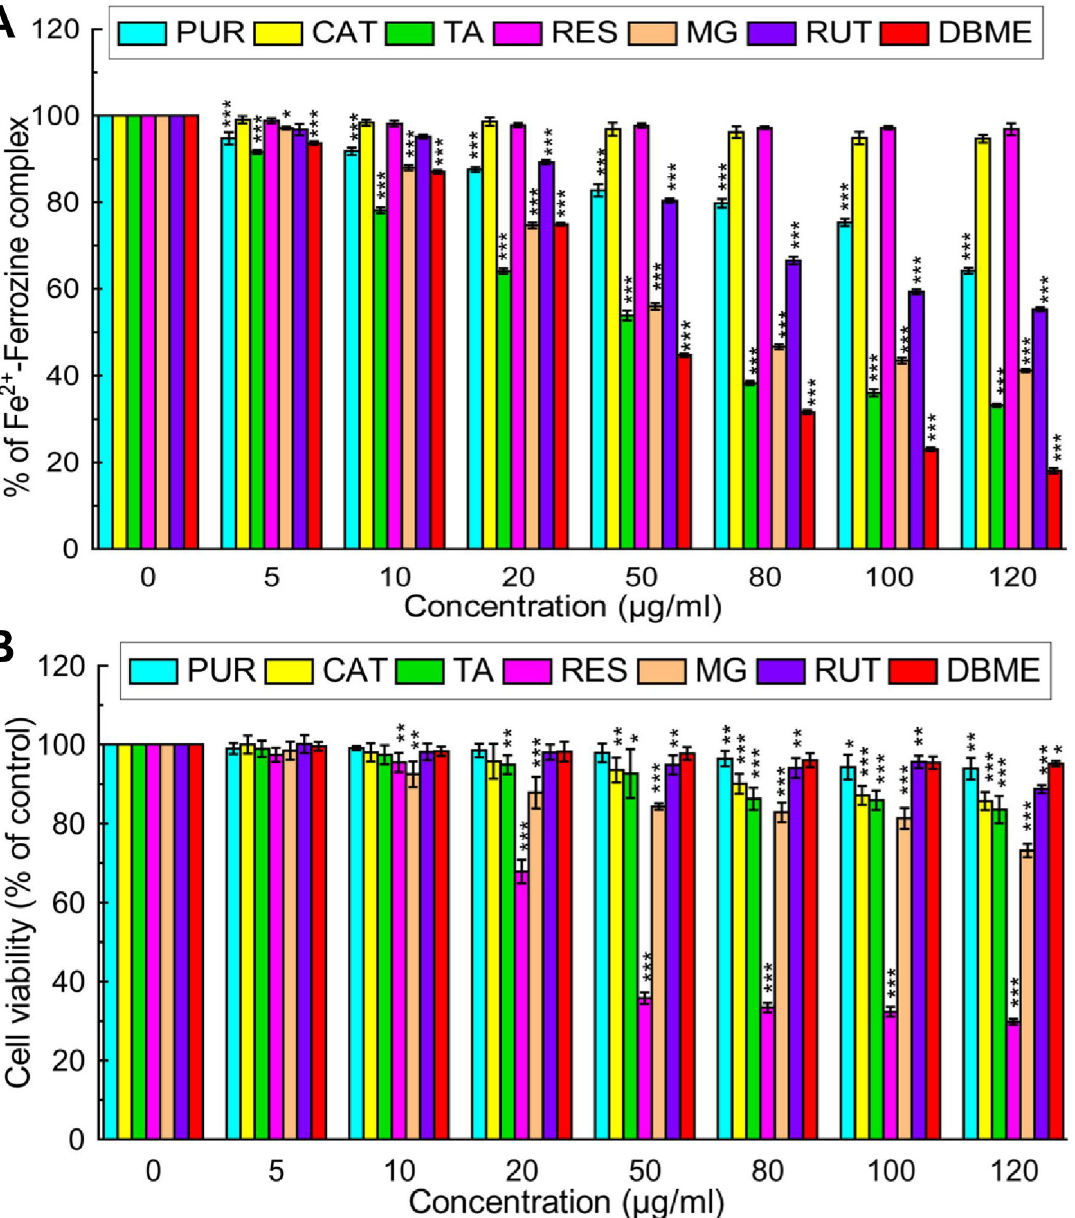
Fig 12. In vitro iron chelation activity and cytotoxicity of various compounds and DBME on normal fibroblast (WI-38) cells. (A) In vitro iron chelation activity of various compounds. (B) WI-38 cells were treated with increasing concentrations of compounds for 48 hours; cell proliferation and viability was determined with WST-1 cell proliferation reagent. Results were expressed as cell viability (% of control). All data is expressed as mean ± SD (n = 6). * p < 0.05, ** p < 0.01 and *** p < 0.001 vs. 0 μ